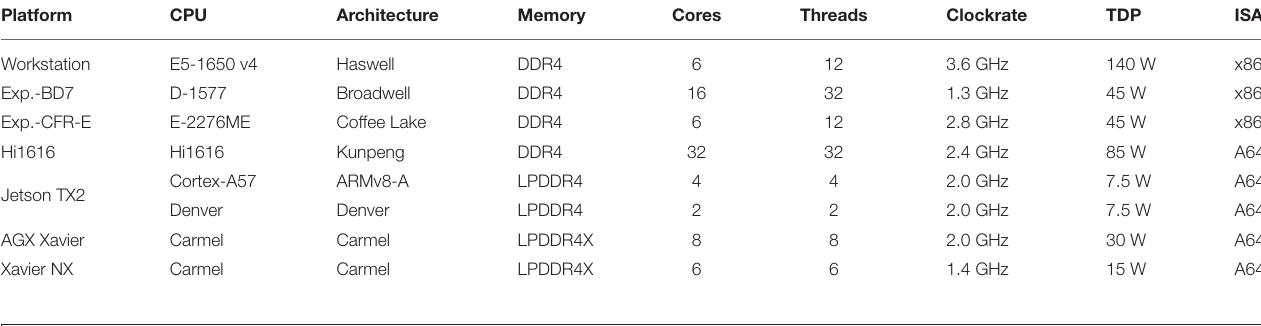
TABLE 9 | Overview of the different platforms and their distinctive features. Platform